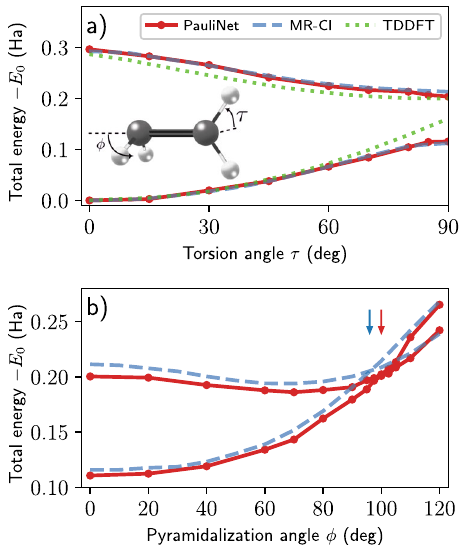
Fig. 5 | Modeling a conical intersection of ethylene. Inset: Ethylene structure. a Total energies (relative to the ground state of the planar geometry E 0 ) of the groundstateand fi rst-excitedsingletstateasafunctionoftorsionangle τ ,withMR- CI 50 and TDDFT 48 results also plotted for comparison. TDDFT overestimates the barrier(thegroundstateat τ =90°)andproducesanunphysicalcusp,whiletheMR- CI results which predict an avoided crossing are well reproduced by PauliNet. b Same as above but as a function of pyramidalization angle ϕ ( τ =90°), with the degeneracy of the two states producing a conical intersection. The arrows denote the conical intersection, withPauliNet ( ϕ ~100°) closelymatching the MR-CI result ( ϕ ~96°). Note: The geometric parameters (bond lengths and angles) vary slightly betweenthetorsionandpyramidalizationexperiments(seeref. 50